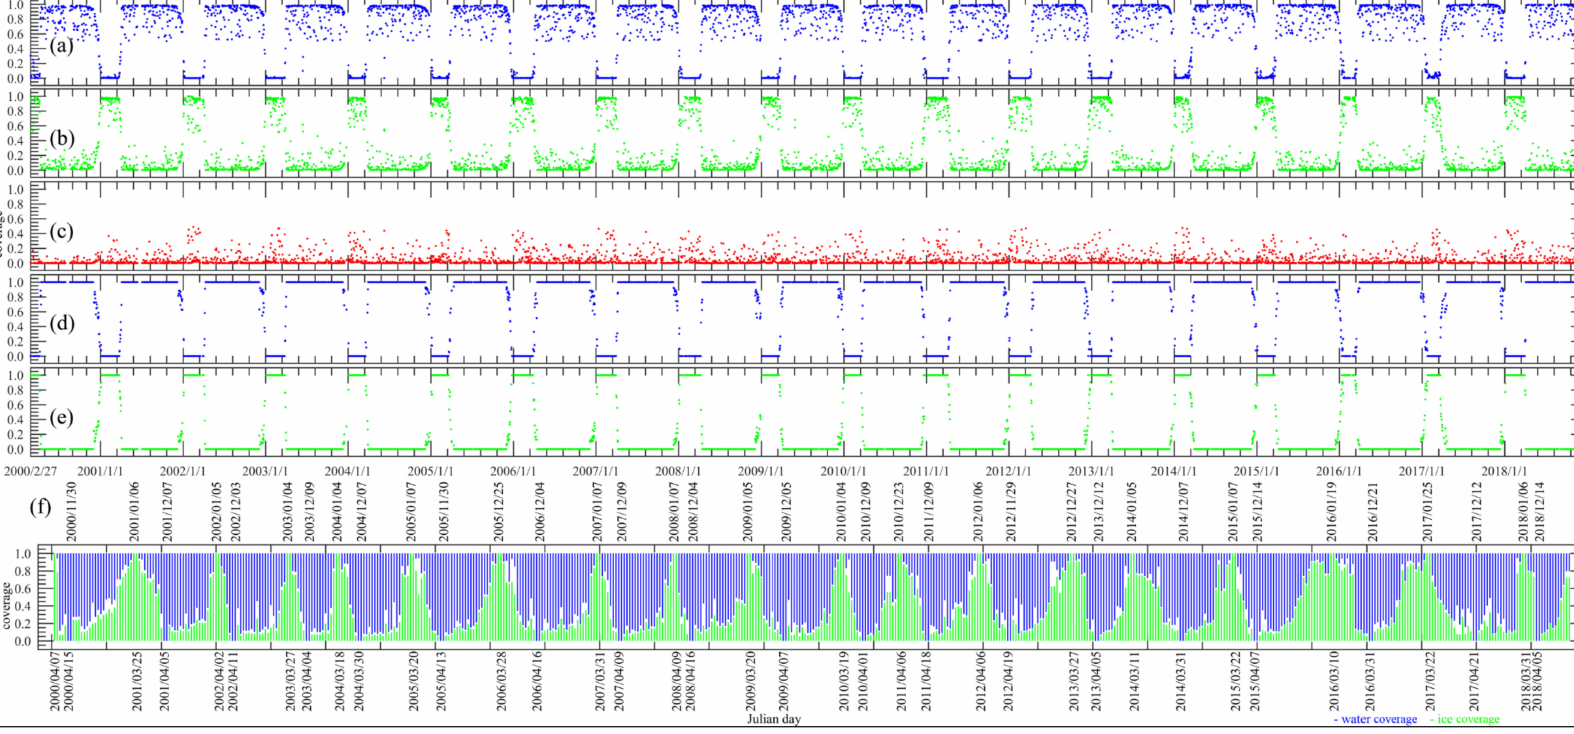
Figure 7. Water coverage, ice coverage, and cloud coverage from 2000 to 2018 ( a ). water coverage; ( b ). ice coverage; ( c ). cloud coverage; ( d ). water coverage through cloud filtering; ( e ). ice coverage through cloud filtering; ( f ). water coverage, ice coverage, and four dates during each ice season, the bottom of the x-axis are pairs of serial BUS and BUE, and the top of the x-axis are pairs of continuous FUS and FUE for each ice season; only the freeze-up and break-up processes were displayed, full ice cover and full water cover processes were not displayed. Blue dot, green dot, and red dot represent water, ice, and cloud,